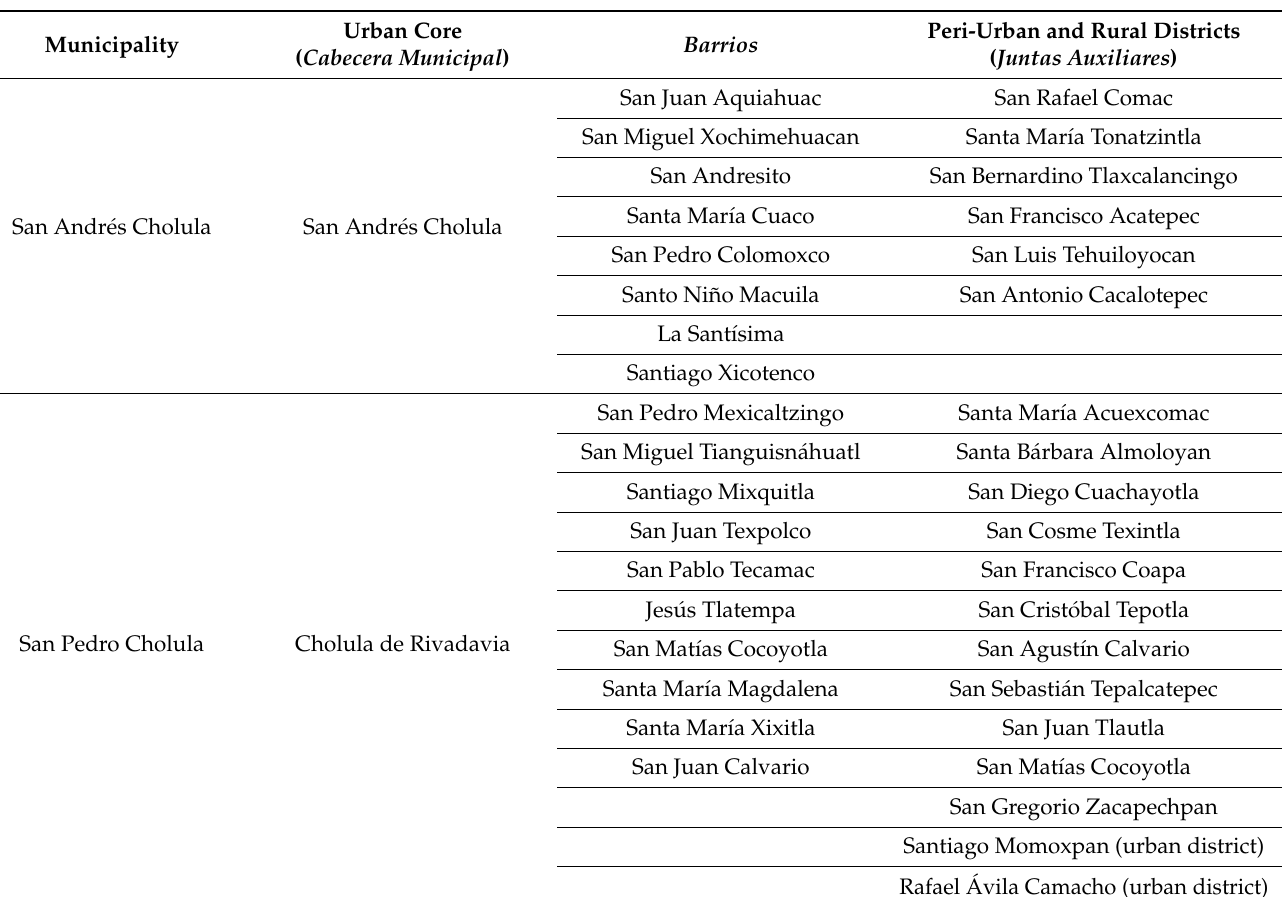
Peri-Urban and Rural Barrios